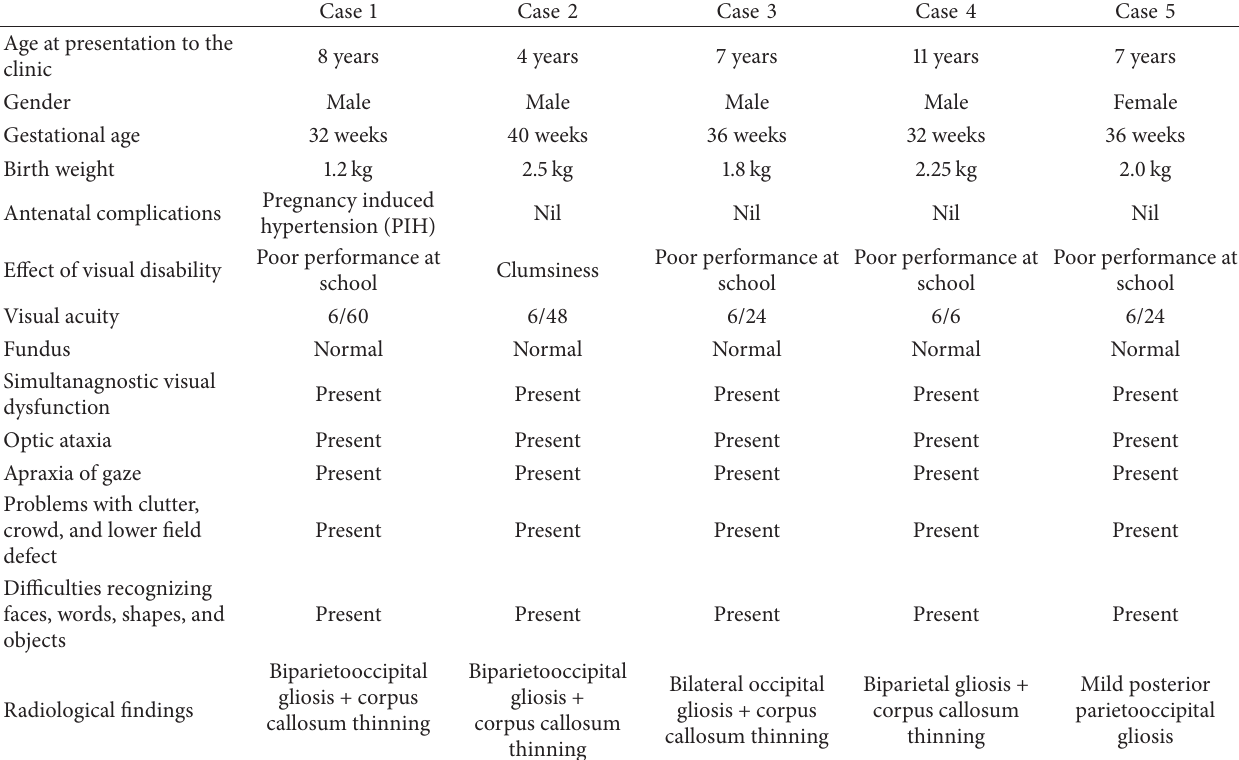
Table 1: Profiles of children with features of Balint’s